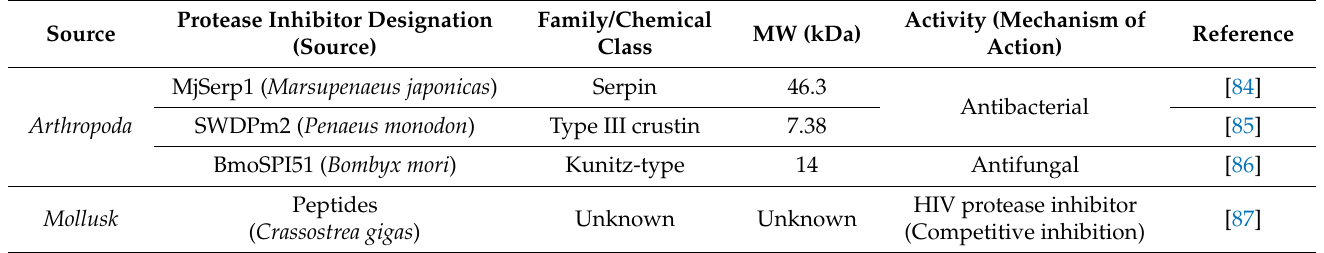
Table 2. Protease inhibitors derived from invertebrates with antimicrobial